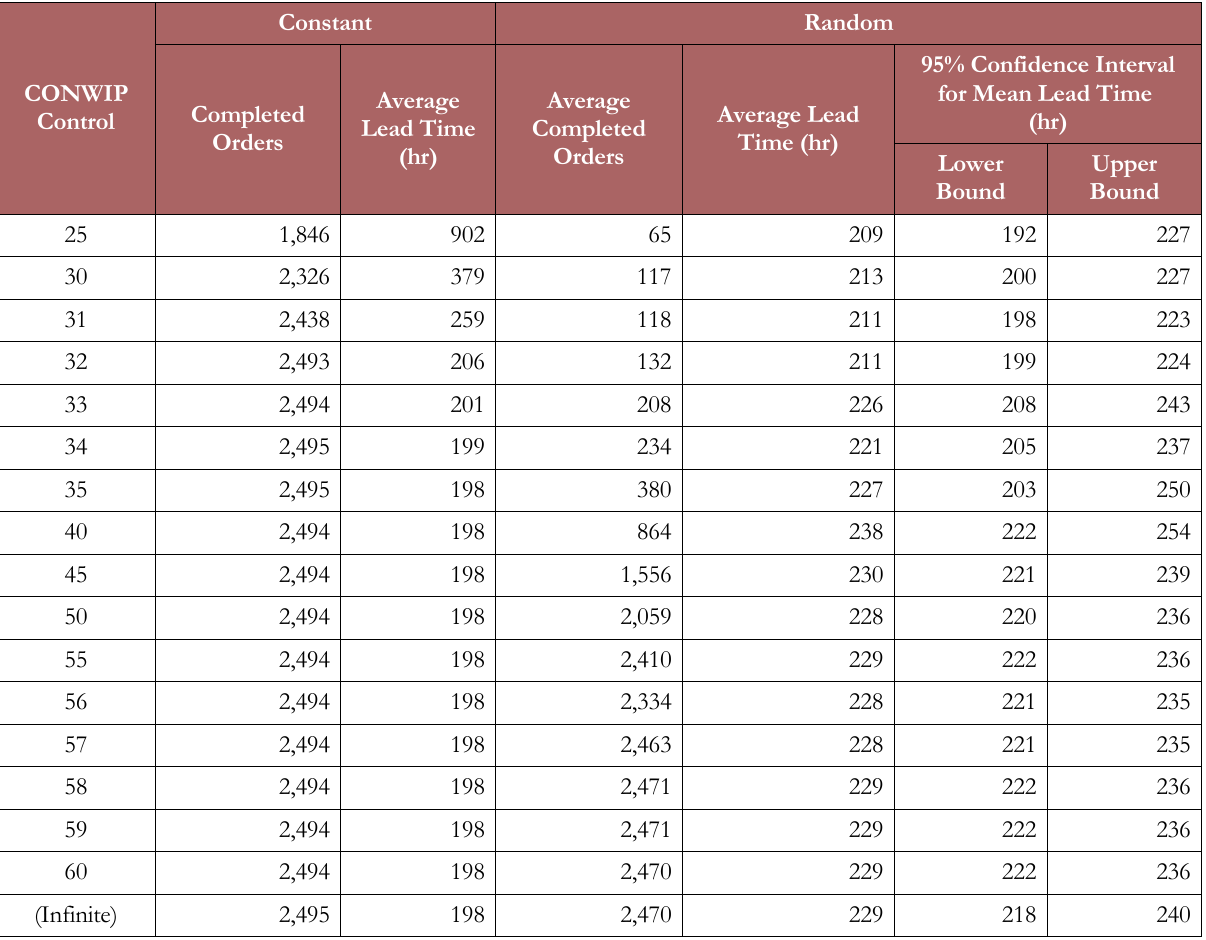
Table 8. CONWIP Parameter Control Simulation